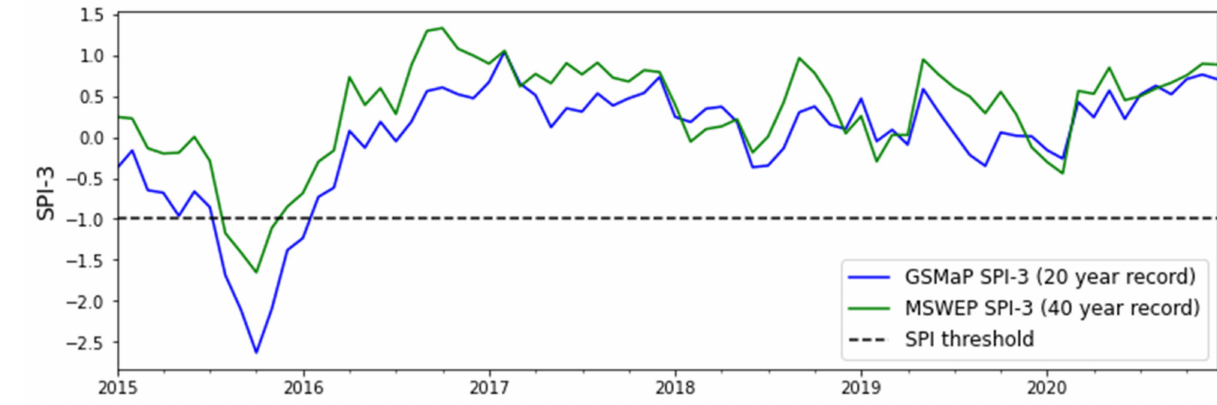
Figure 4. Three-month Standardised Precipitation Index averaged over PNG from 2015 to 2020 for the two datasets analysed in this study—GSMaP and MSWEP.